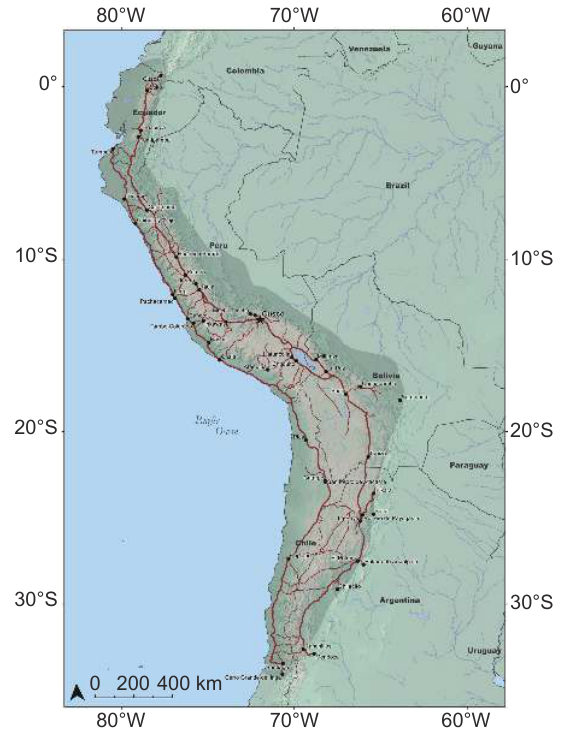
Fig. 1 Tawantinsuyu (gray area), showing major imperial roads and centers. Road and settlement data based on D’Altroy 2017 [15]